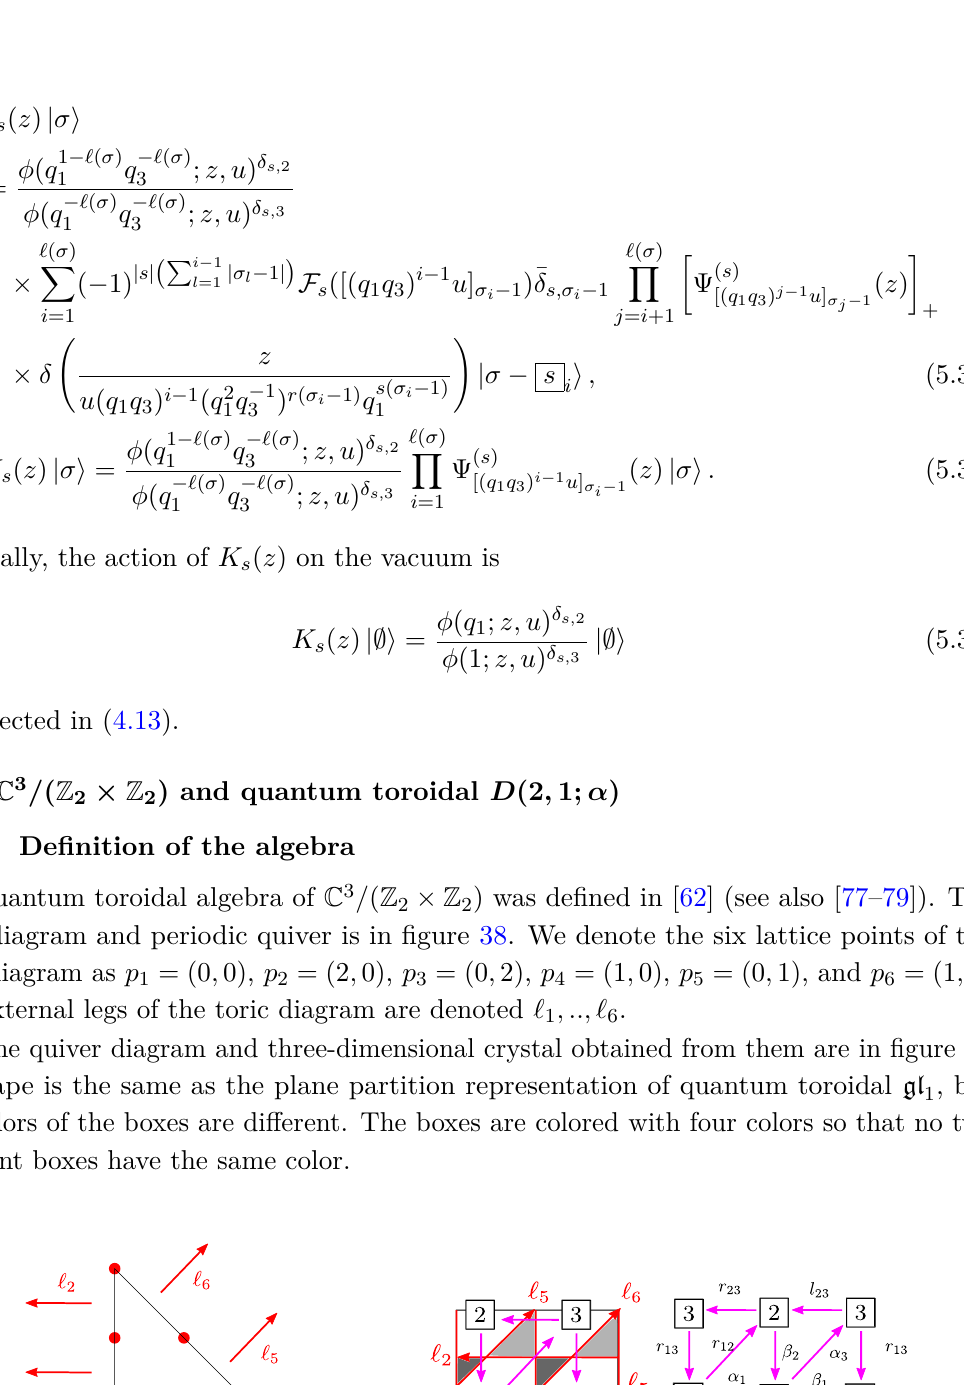
= (2 , 0) , p = (0 , 2) , p = 2 3 4 ( i = 1 , .., 6) i